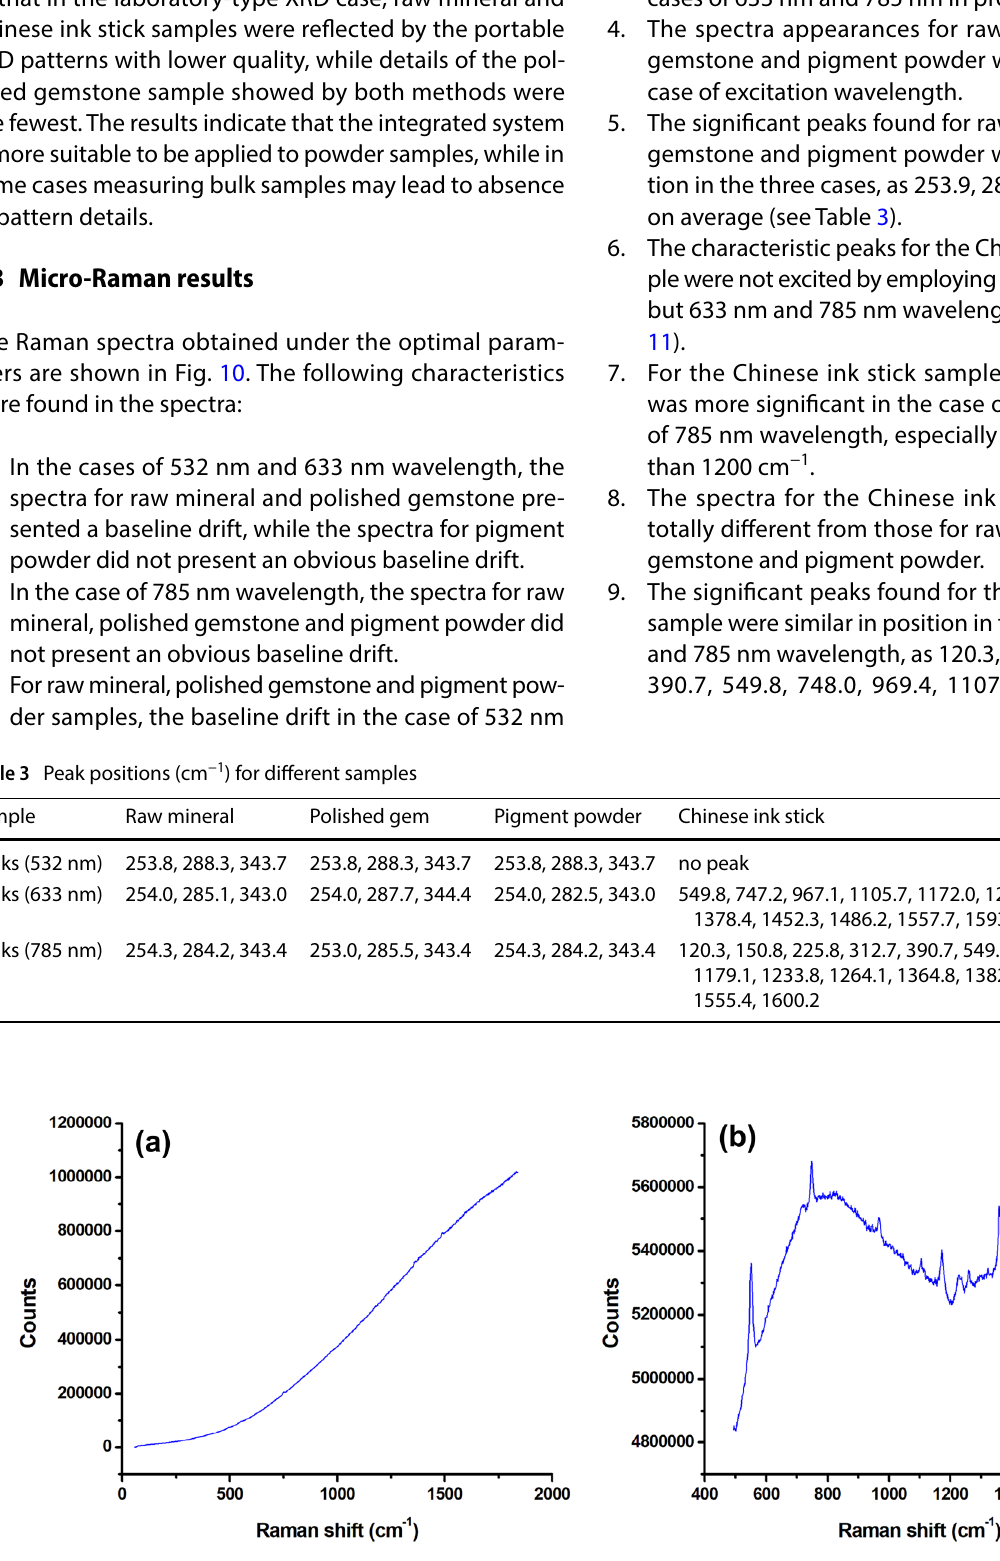
Fig. 11 Raman spectra for Chinese ink stick excited by a 532 nm laser and b 633 nm